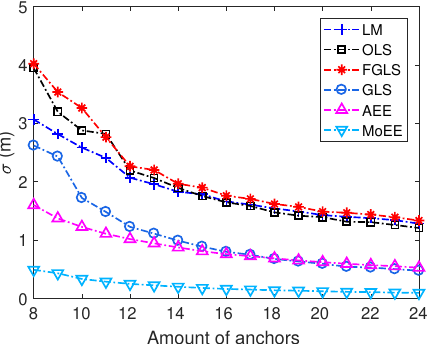
Fig. 7 Effects of the amount of anchors with non-IID error.